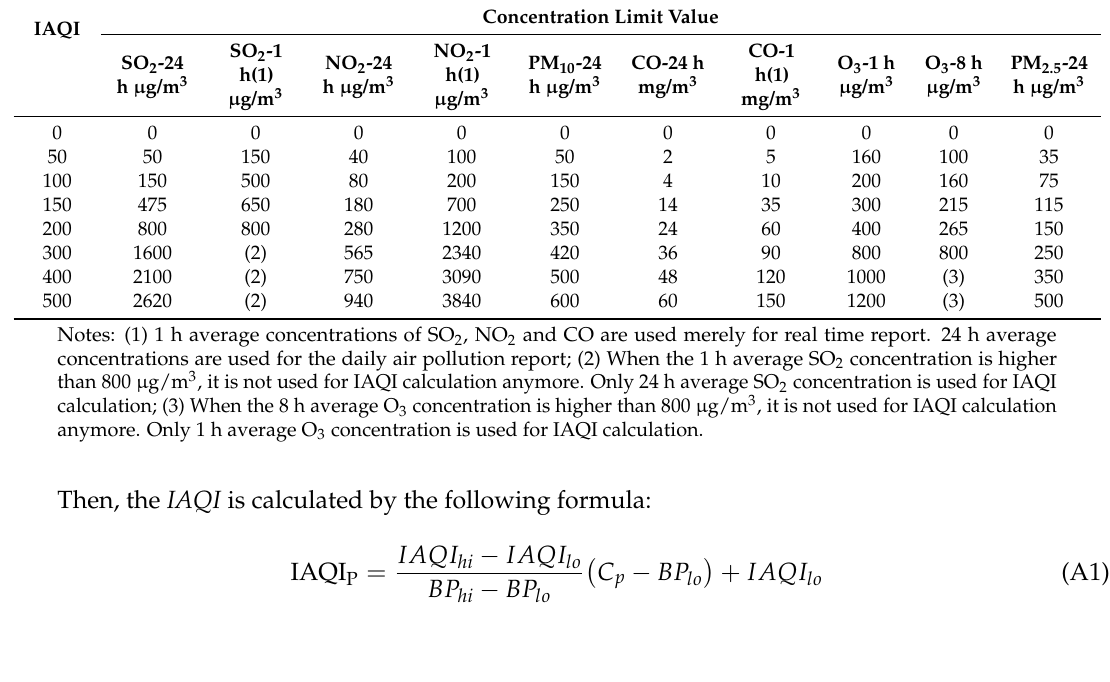
Table A1. The corresponding concentration limit value for individual air quality index (IAQI).